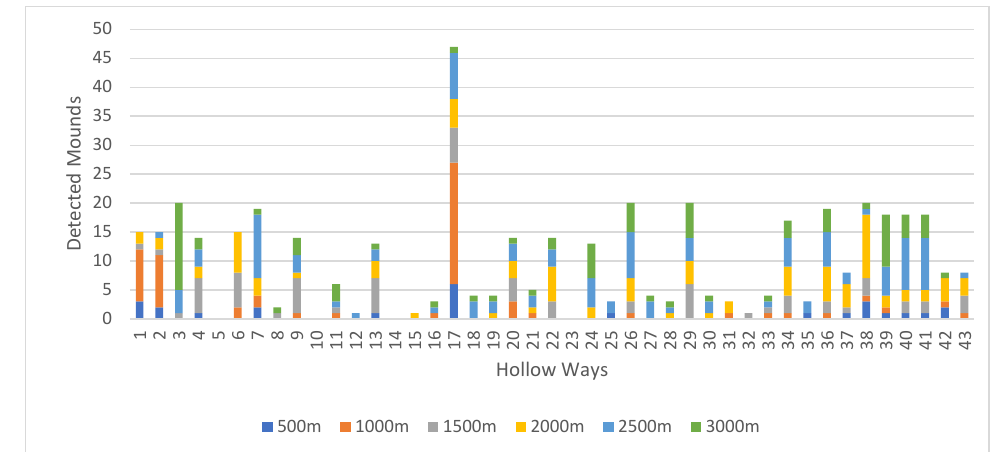
Figure 12. Detected mounds around each hollow way. The colors correspond to the zone, in which the mounds are located, and are also to be found in Table 1. Table 1. Detailed list of all results. Numbers that are referenced in the text are highlighted.